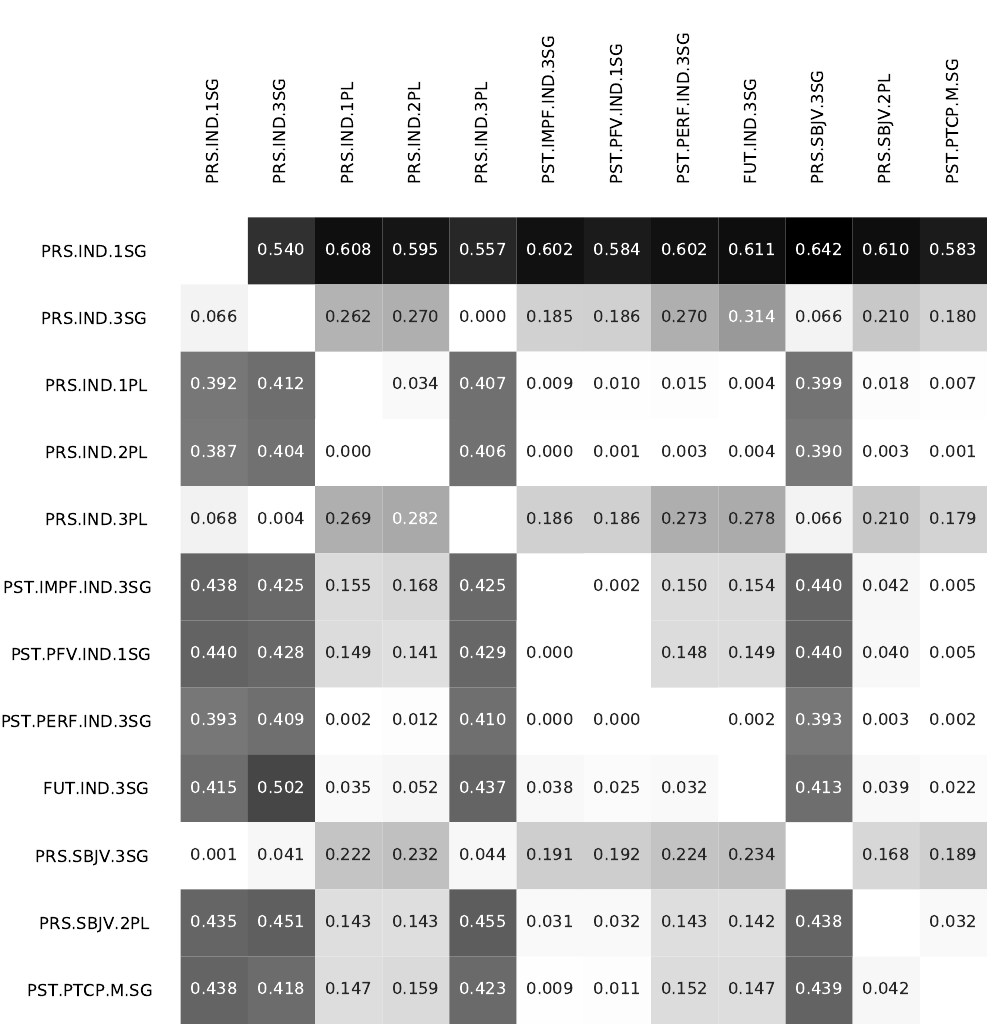
Figure 2: Conditional entropy within the distillation from Table